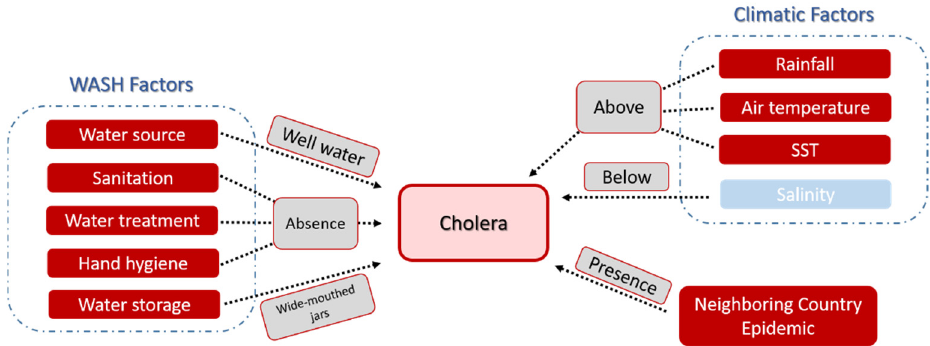
Figure 5. Diagram showing the adaptation to Guinea-Bissau of the influence of different stressors on cholera transmission. Red and blue boxes indicate positive and negative relationships, respectively. SST—sea surface temperature.